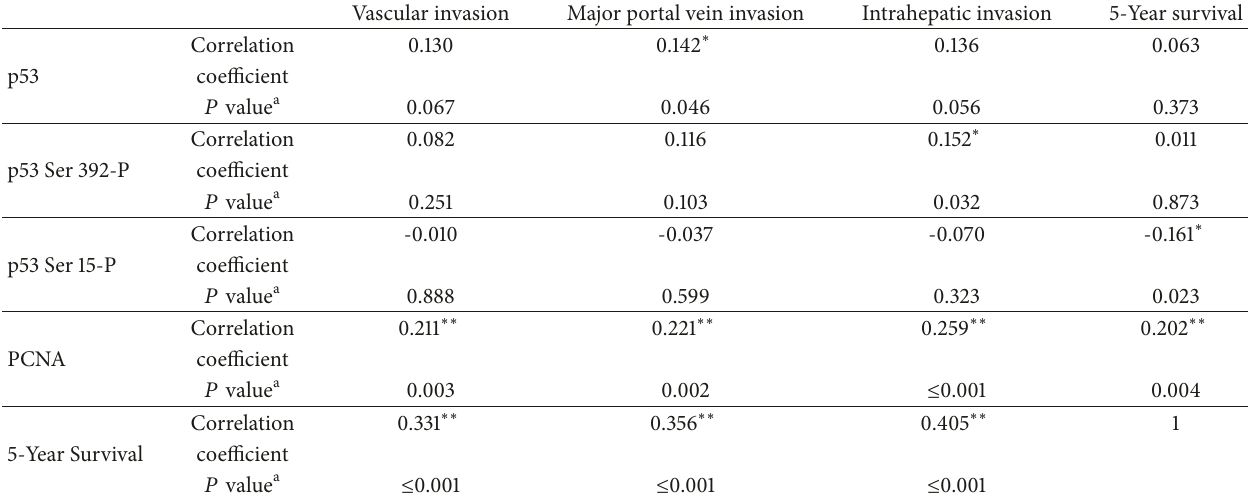
Table 4: Correlation between p53, p53 serine-P, PCNA, and clinicopathological factors.